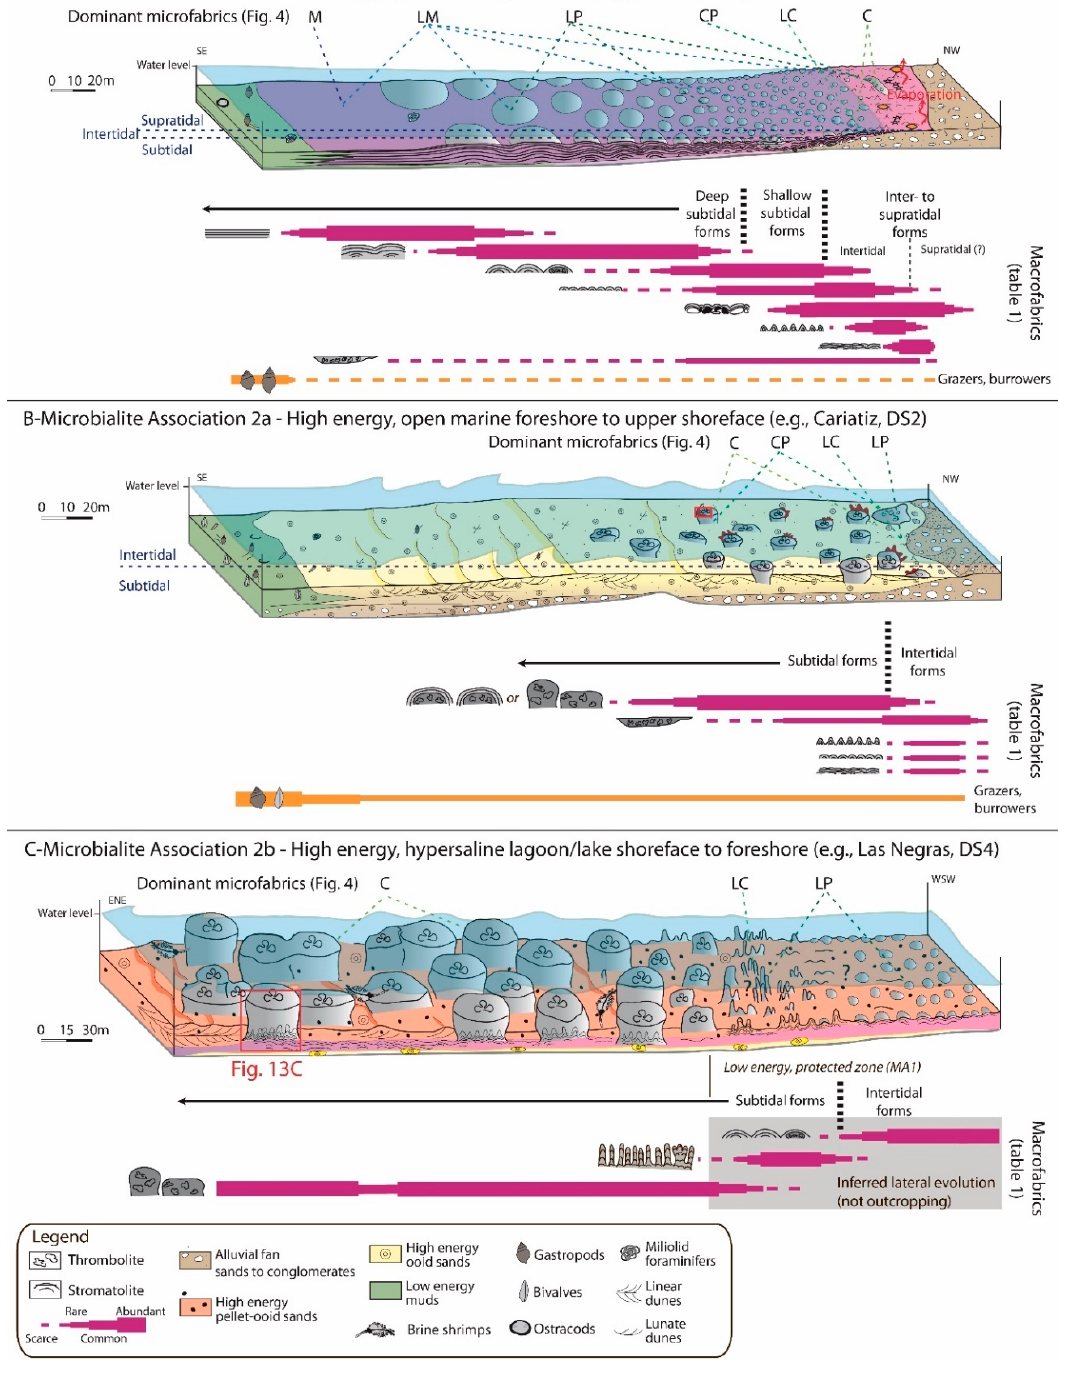
Figure 5. Microbialite associations with the spatial distribution of microbialites macro ‐ , meso ‐ , and micro ‐ fabrics along three depositional profiles. The position of each example is indicated in Figure 2. ( A ) Microbialite Association 1 (MA1) is a low energy, hypersaline lake or lagoon association. ( B ) Microbialite Association 2a (MA2a) is a high energy, normal marine association. ( C ) Microbialite Association 2b (MA2b) is a high energy, hypersaline association.